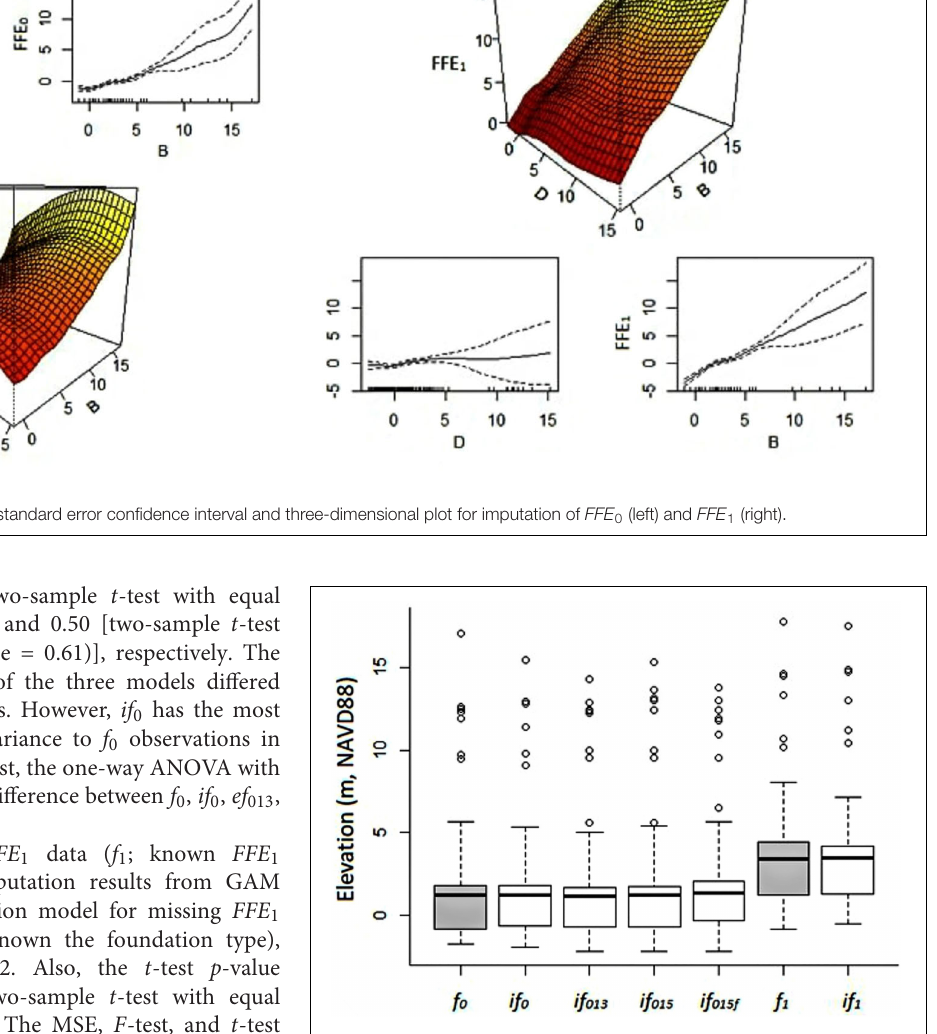
FIGURE 5 | Boxplots of imputed and estimated FFE 0 and FFE 1 compared to FFE 0 and FFE 1 data from